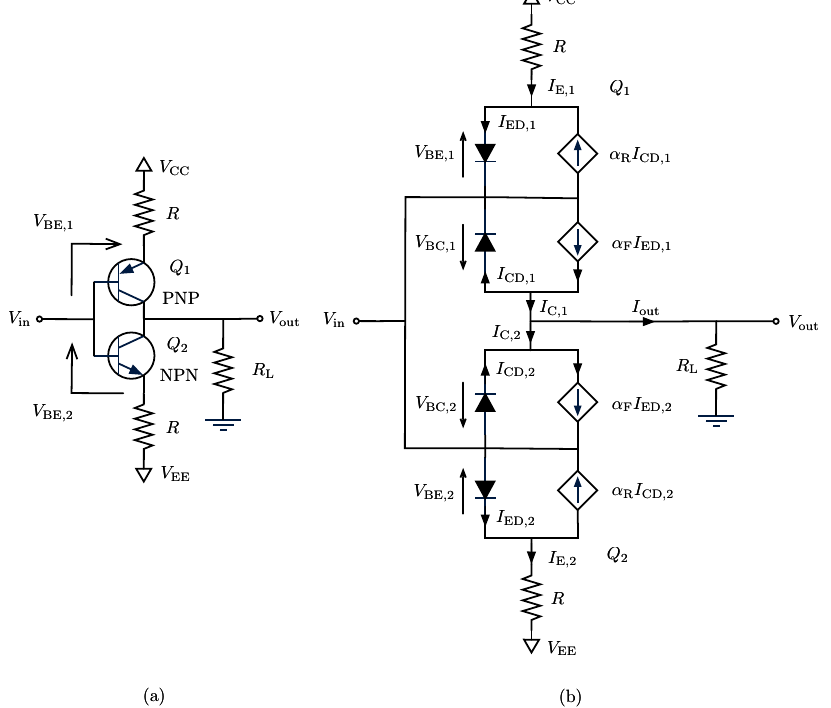
Figure 1. ( a ) Simplified schematic of the Lockhart wavefolder circuit (adapted from [53]); and ( b ) its Ebers–Moll large-signal equivalent